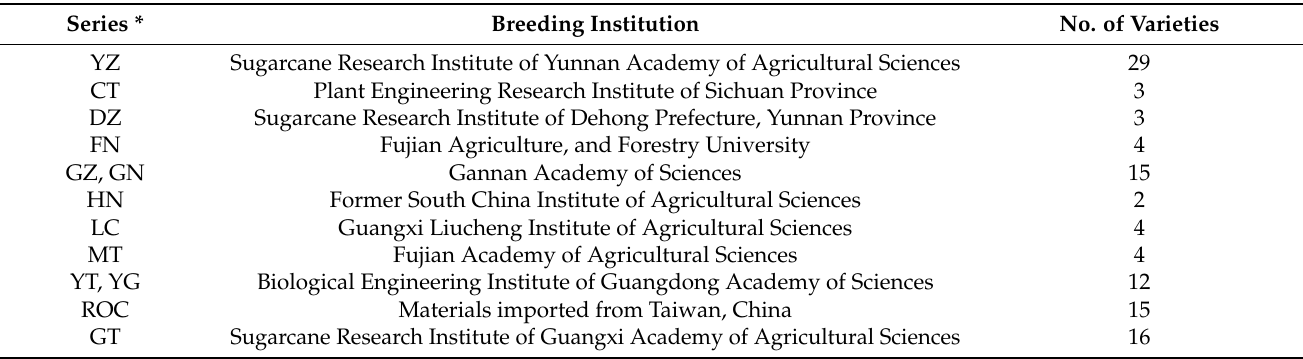
Table 1. Test varieties and breeding institutions where they were